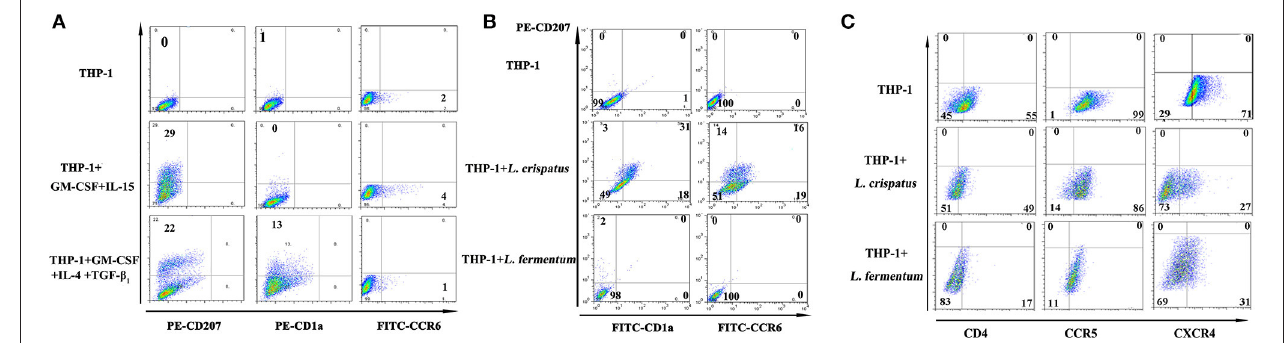
FIGURE 4 | Langerhans cell markers and and HIV-1 receptors on THP-1 after stimulation with lactobacilli. (A) CD207, CD1a, and CCR6 expression on the surface of THP-1 stimulated with GM-CSF and IL-15 or GM-CSF, IL-4, and TGF- β 1 . (B) CD207, CD1a, and CCR6 expression on the surface of THP-1 stimulated with L. crispatus and L. fermentum . (C) HIV-1 receptors (CD4, CCR5, and CXCR4) expression on THP-1 after stimulation with L. crispatus and L. fermentum .